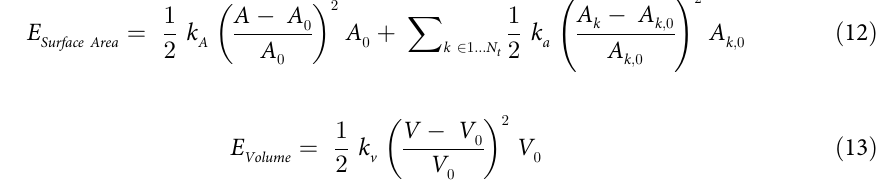
at j th link. The shaded planer area is the area associated with the j th link. n j